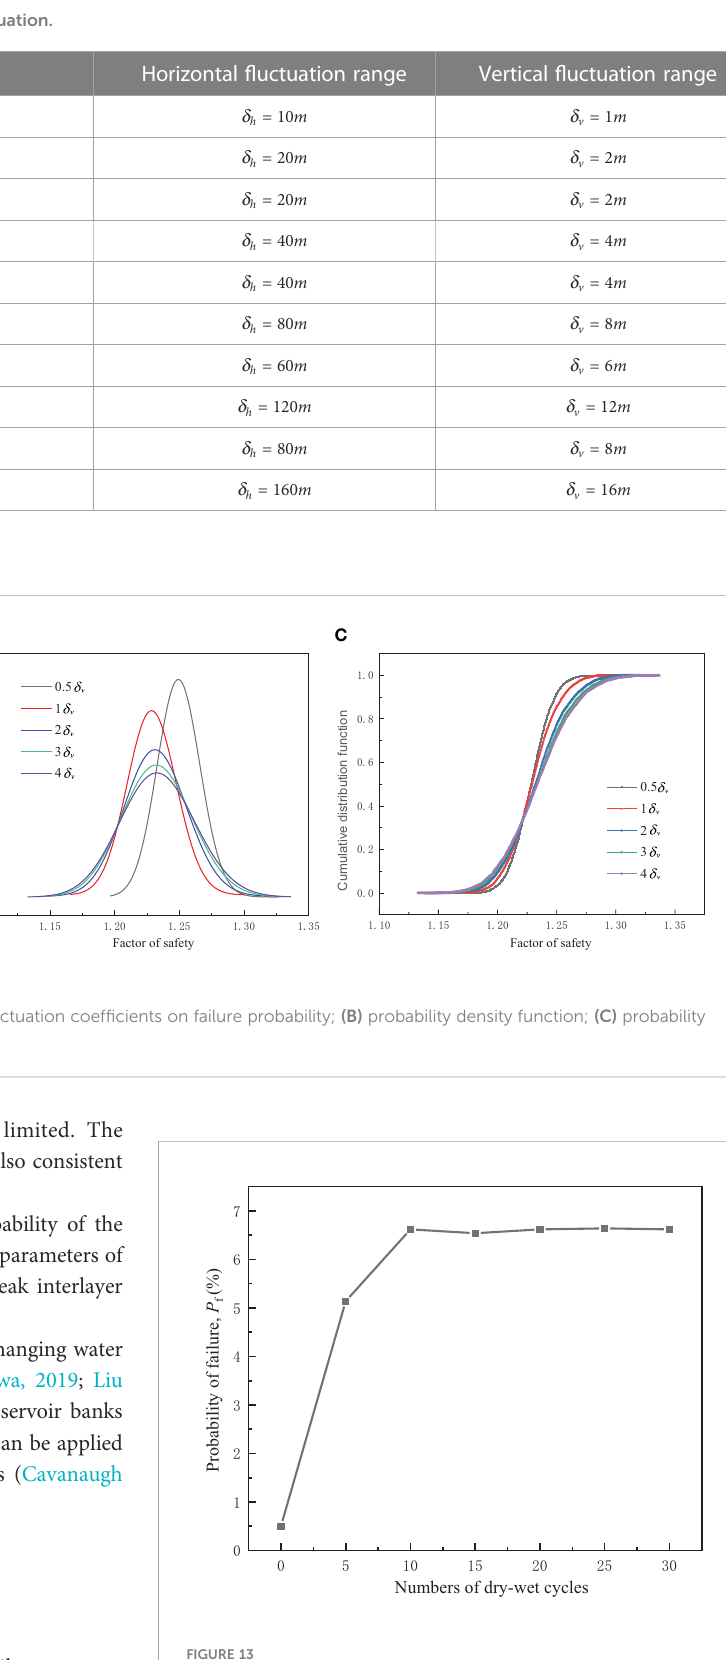
FIGURE 13 In fl uence of parameters degradation of sliding body and weak interlayer on failure probability under dry-wet cycles.